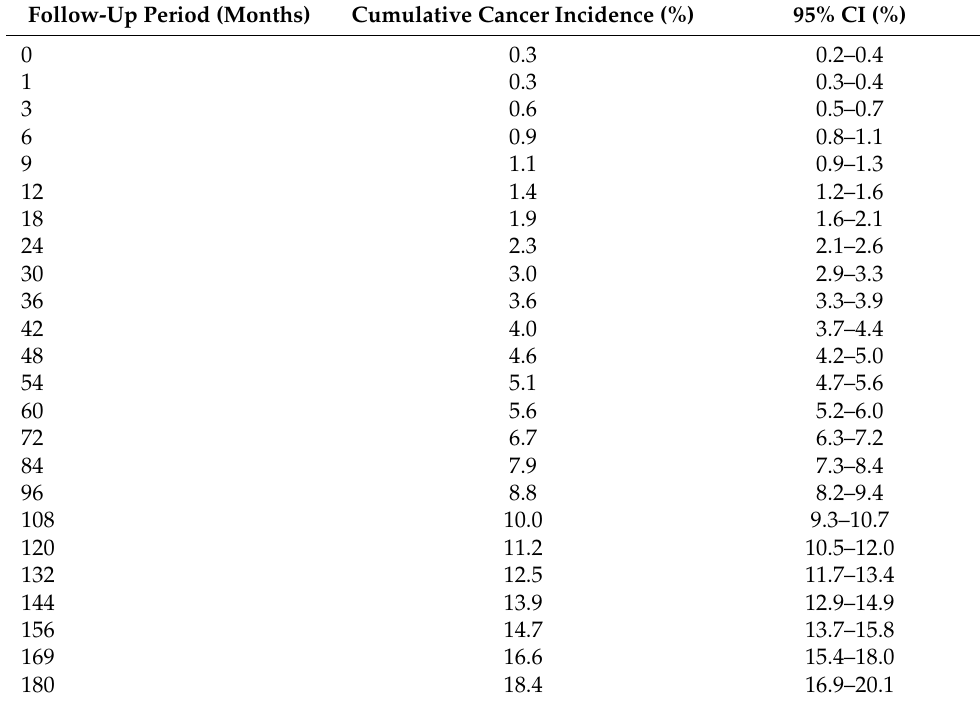
Table 3. Cumulative incidence of all de novo primary cancers according to length of the follow-up after kidney transplantation by Kaplan–Meier